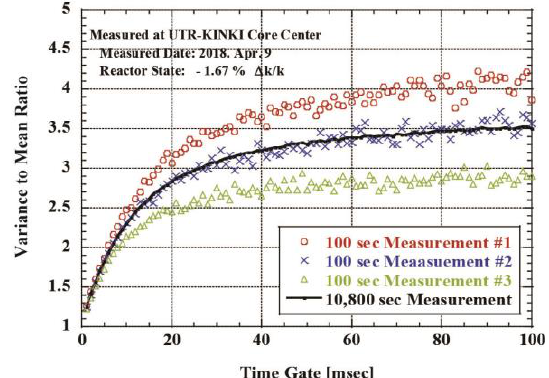
Figure 3. An example of measurement result for actual